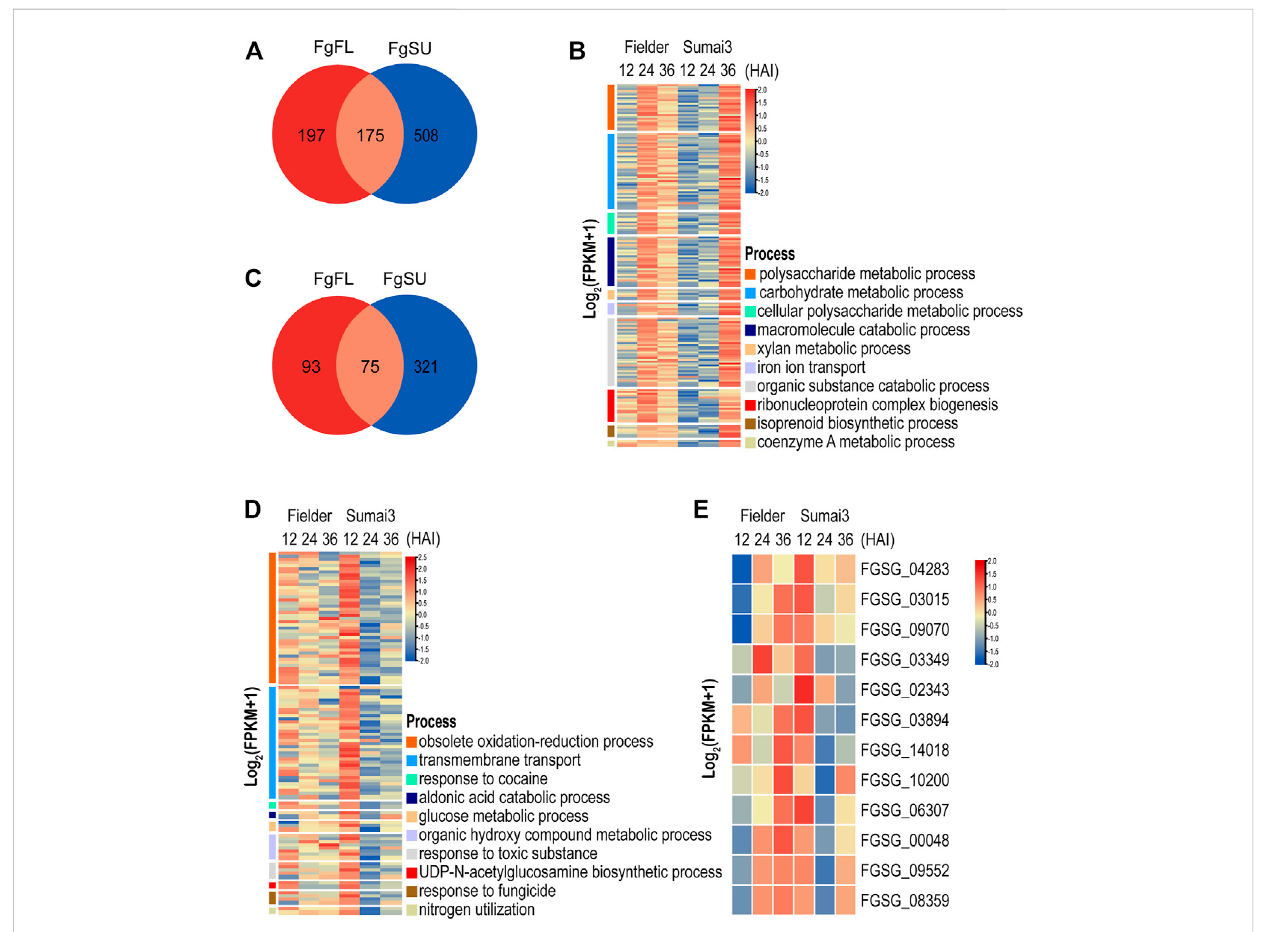
FIGURE 4 Temporal expression pattern and function analysesof DEGs that werespeci fi cally upregulated or downregulated in resistant host (A) Distribution of DEGsthatwereupregulatedindifferenthosts. (B) GOtermssigni fi cantlyassociatedwithDEGsspeci fi callyupregulatedinresistanthost. (C) Distributionof DEGs that were downregulated in different hosts. (D) GO terms signi fi cantly associated with DEGs speci fi cally downregulated in resistant host. (E) Heatmap of DEGs that were upregulated in susceptible host but downregulated in resistant